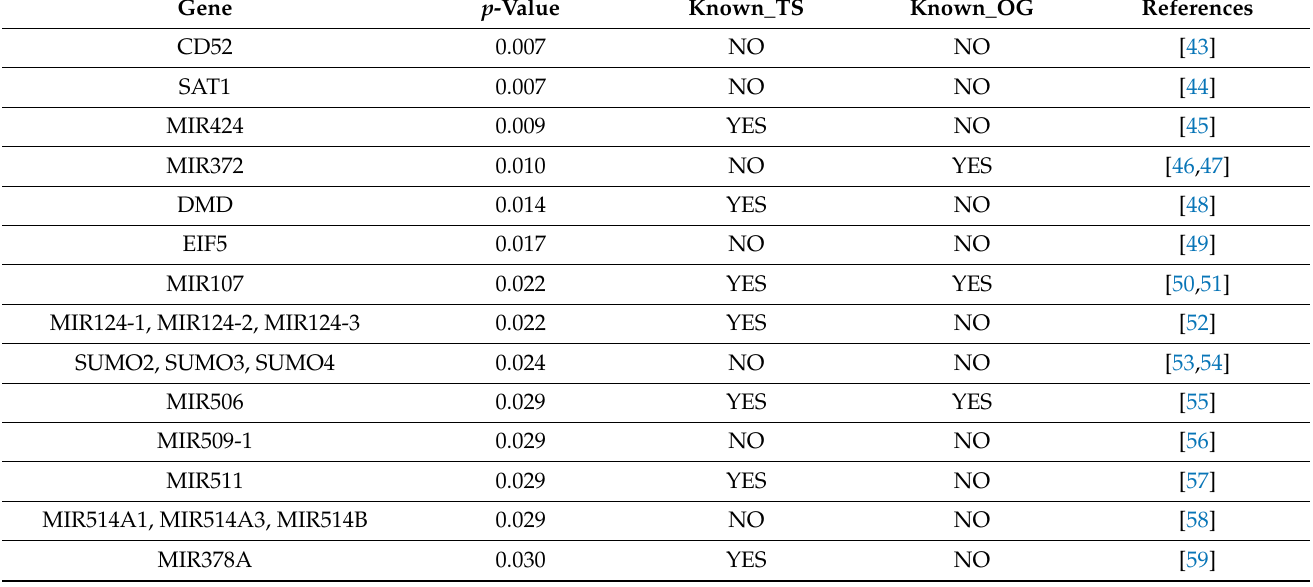
Table 1. Genomic CNV landscape comparisons. Subset of 25 significant hits resulting from